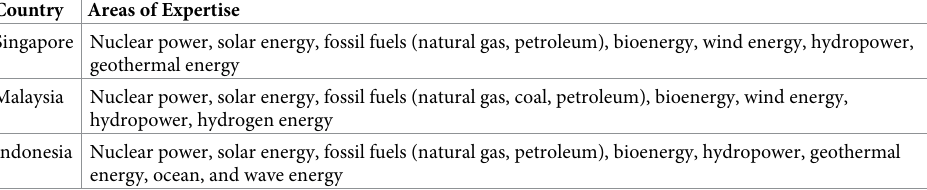
Table 2. Expert participants’ area of energy expertise. Country Areas of